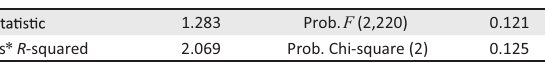
FIGURE 2: Breusch–Godfrey serial correlation LM